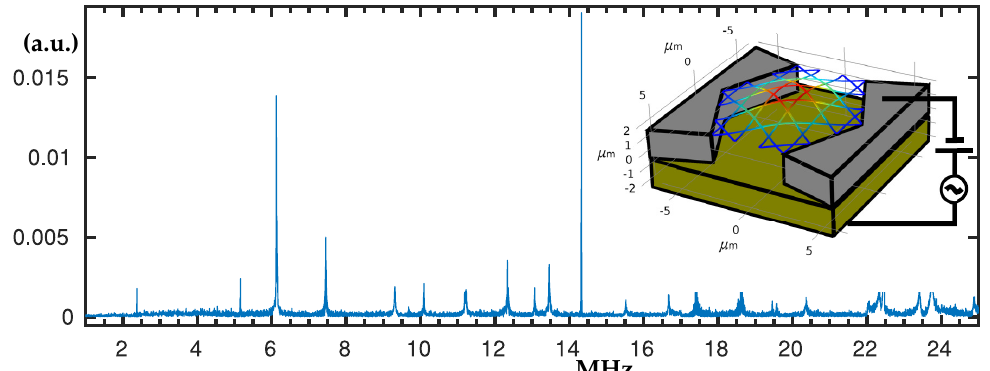
Figure 2. Experimentally measured frequency response spectrum produced by using electrostatic actuation and optical interferometric detection.